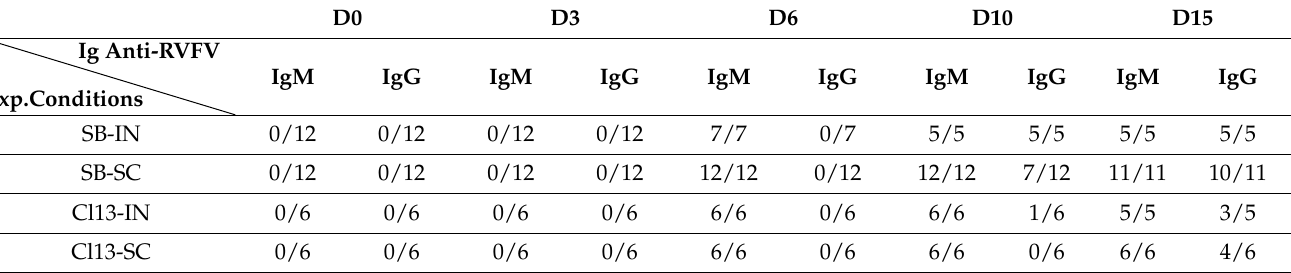
Table 1. Seroconversion of intranasally and subcutaneously infected mice. The presence of anti-RVFV IgM and IgG antibodies in SB- and Cl.13-infected mice was detected by ELISA assays at D0, D3, D6, D10, and D15 p.i. The table indicates the number of IgM or IgG positive mice as well as the total number of mice analyzed at each time point and